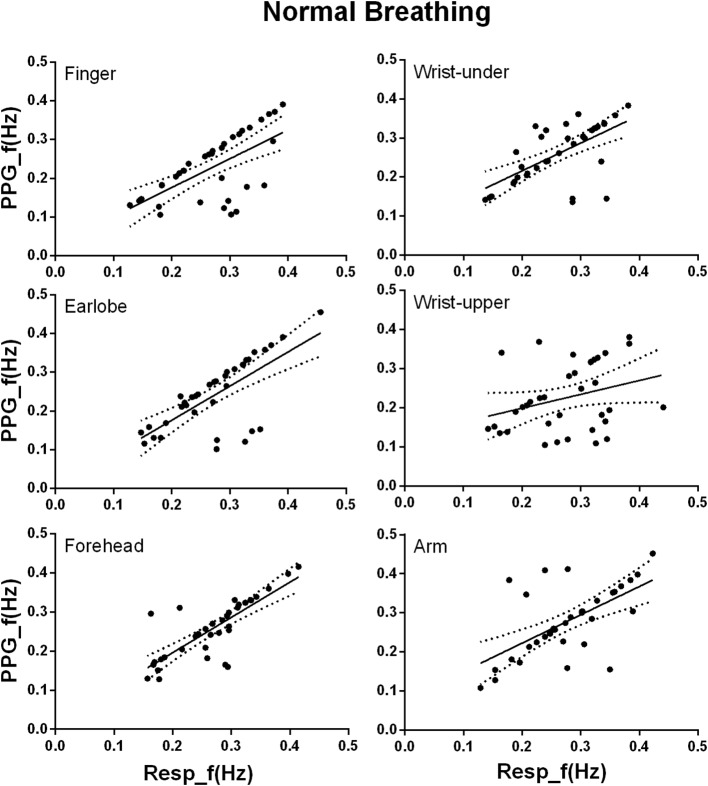
Linear regression of the PPG-derived and reference RFs under normal breathing. The x and y axes denote the reference and PPG-derived RFs, respectively. The points mark the measured data. The solid and dotted lines indicate the best-fit line and its 95% confidence interval, respectively.